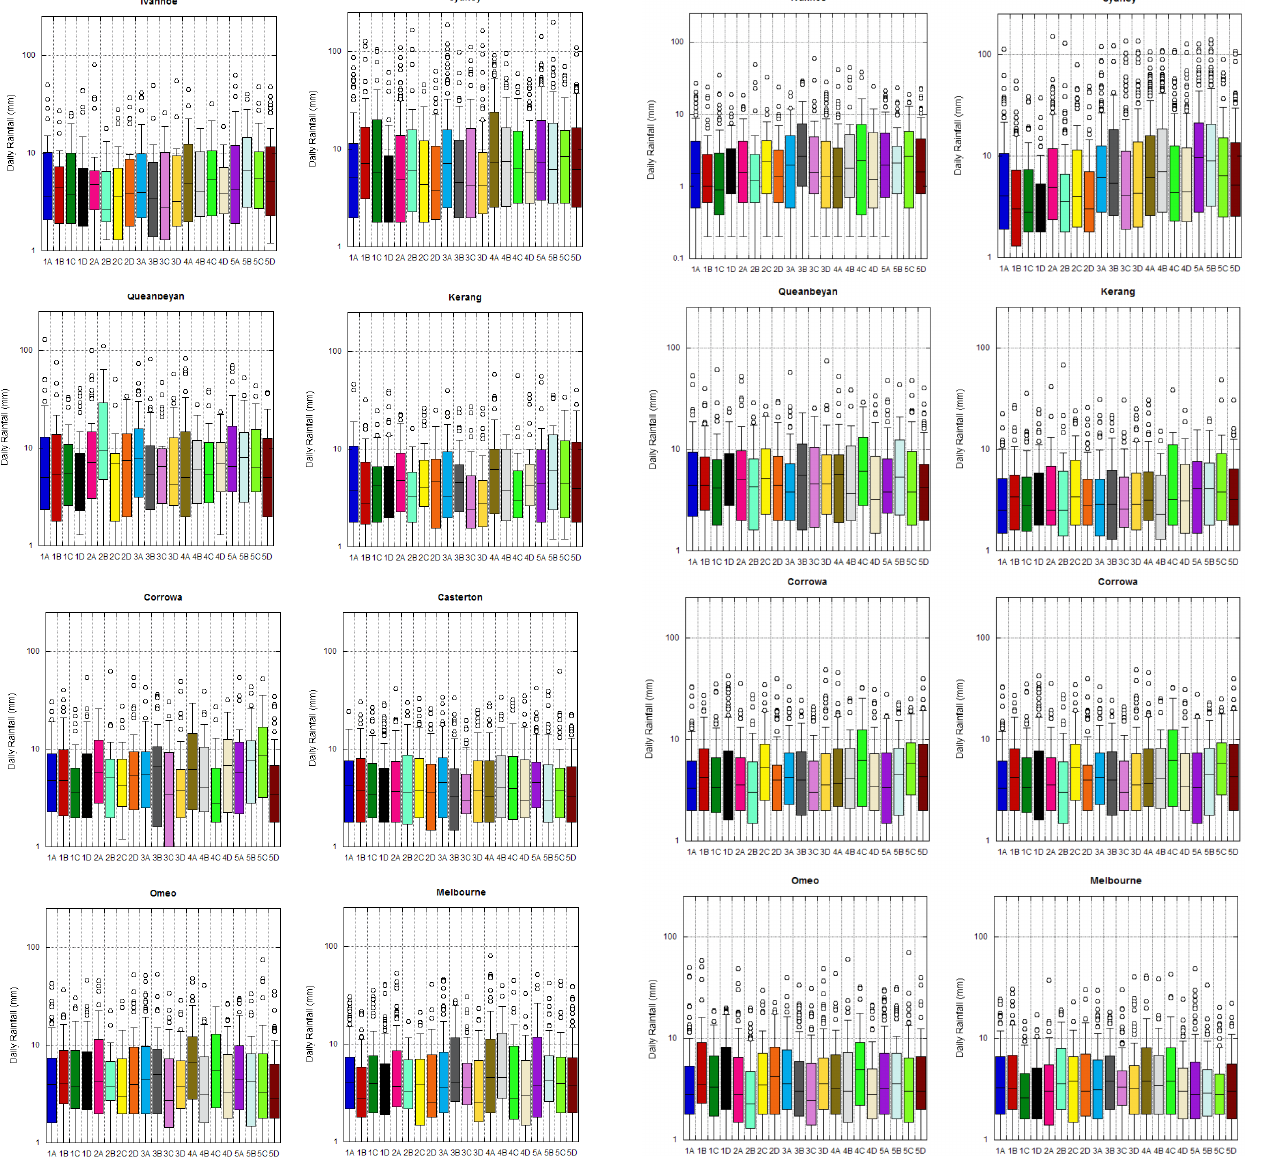
Figure 11. Daily rainfall distributions associated with each autumn synoptic type.